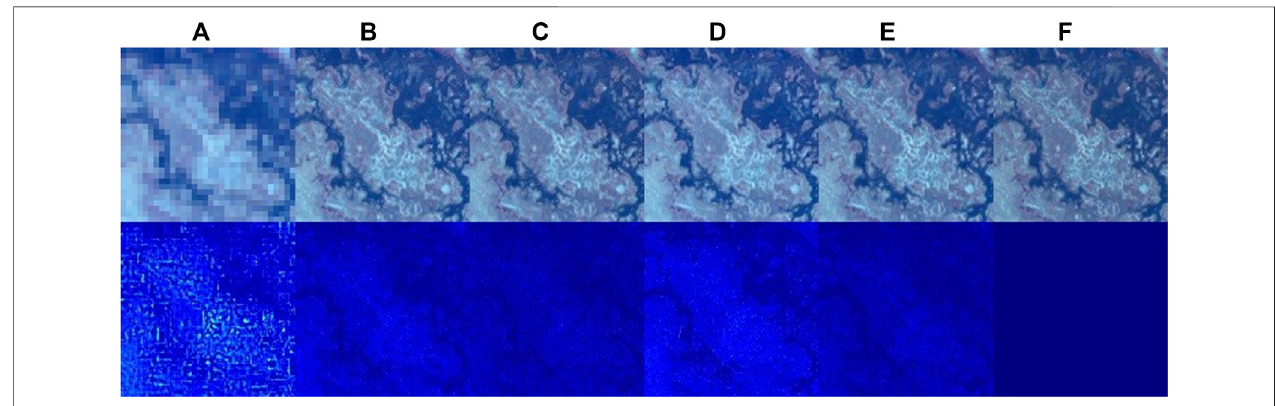
FIGURE 3 | Qualitative comparison on Botswana dataset in case of 4× spatial downsampling. For visualization purposes, three spectral bands (47-14-3) are selectedfromtheoutputdataanddifferenceimagesarecalculatedbasedonthatpreselectedthreebands.The fi rstrowshows (A) inputLRHSI, (B) SSFCNNoutput,